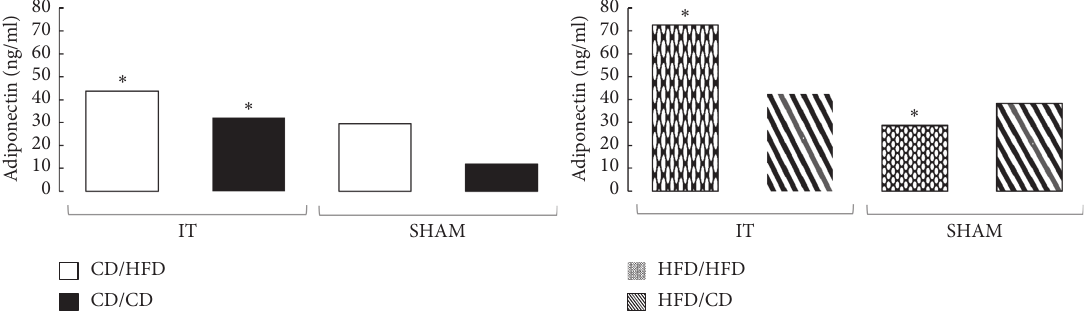
Figure 6: Median of adiponectin plasma concentration in four diet groups according to operation type. Abbreviations: IT—ileal transposition, SHAM—sham operated animals, CD—control diet, and HFD—high-fat diet. Preoperative diet/postoperative diet: CD/HFD, CD/CD, HFD/HFD, HFD/CD (group size: n � 6, except IT HFD/HFD: n � 5). Sign ∗ denotes significant difference between median values; Kruskal–Wallis test, p < 0 . 05. Quartile deviation (Q25 and Q75) available in Supplementary